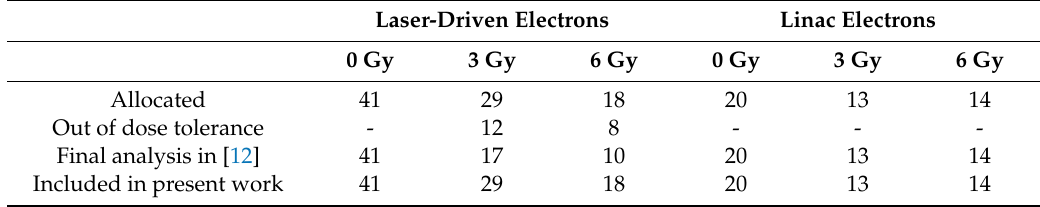
Table 3. Overview of the animals allocated and finally analysed for the electron irradiation experiments described in Oppelt et al. [12] and in this